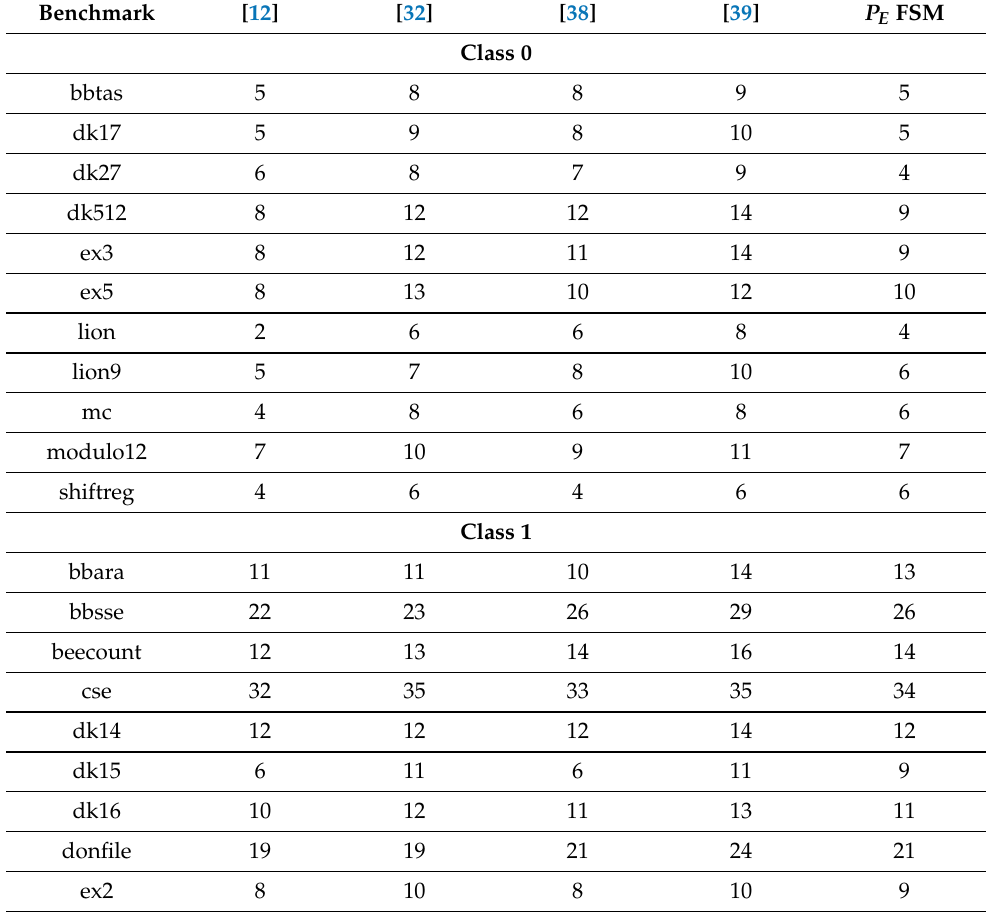
Table 13. Comparison with our previous works (the number of